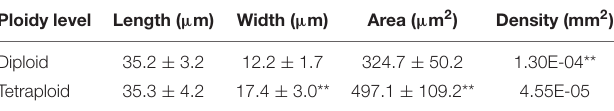
TABLE 6 | Characteristics of stomatal apparatus in diploid and tetraploid garlic